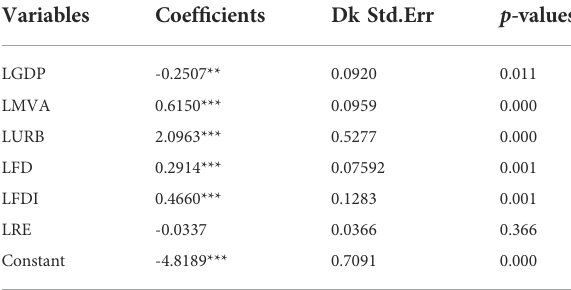
TABLE 7 Long-run Results Driscoll-Kraay (DK)